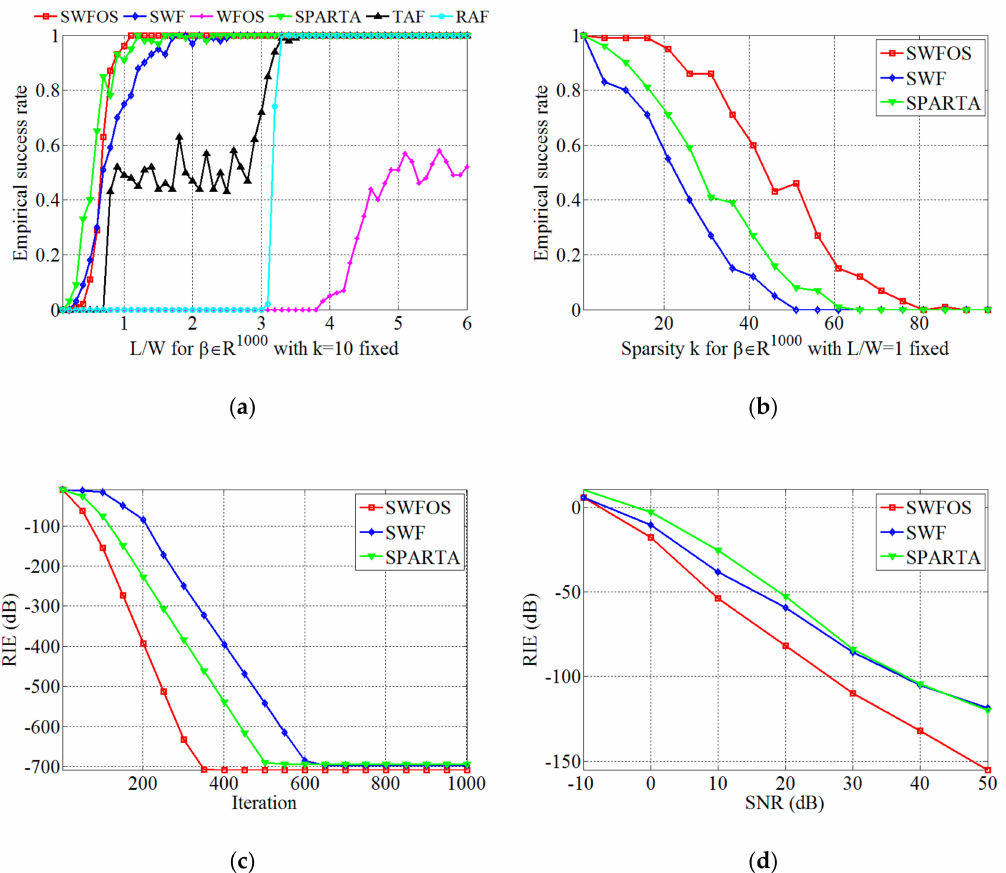
Figure 2. Performance results of the sparse Wirtinger flow algorithm with optimal stepsize (SWFOS) algorithm with other algorithms in the complex case: ( a ) empirical success rates for di ff erent L / W at fixed k = 10; ( b ) empirical success rates for di ff erent k at fixed L / W = 1; ( c ) relative imaging errors (RIEs) for di ff erent number of iterations at same condition; and ( d ) RIEs for di ff erent SNRs at same